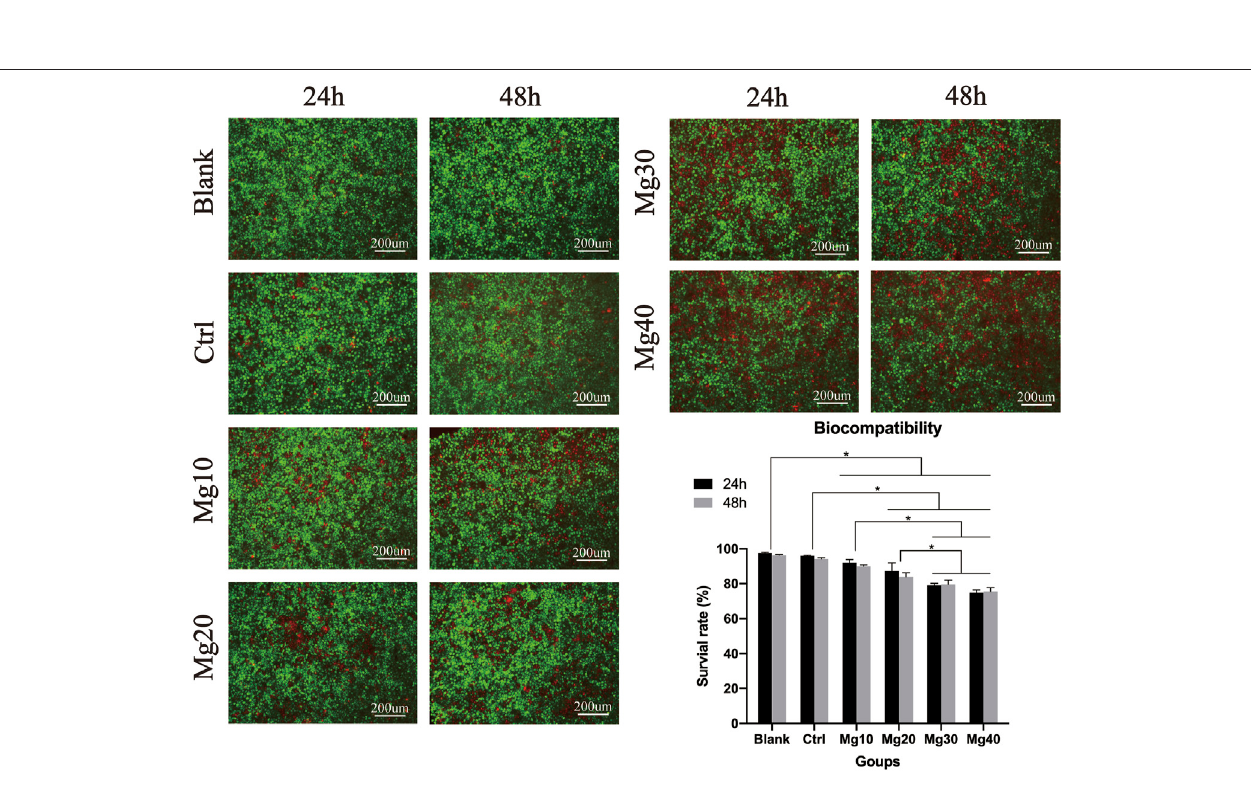
Frontiers in Bioengineering and Biotechnology |